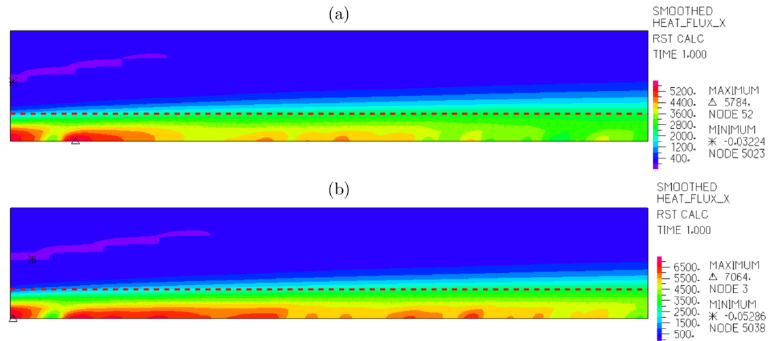
Figure 13. Distribution of heat flux in the fluid obtained from the FEM computations carried out by ADINA software; the data for the test section with five minichannels; experimental parameters listed in Table 2, heat flux values: ( a ) q’’ = 13.8 kW/m 2 ; ( b ) q’’ = 55.8 kW/m 2 .